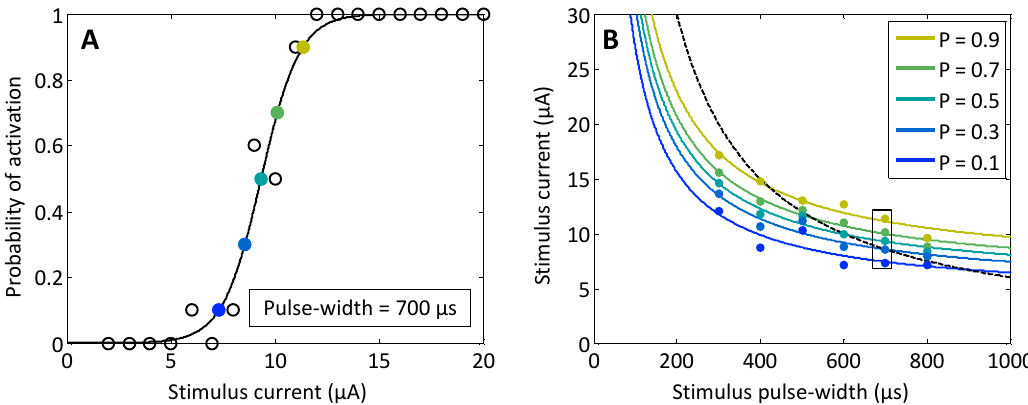
Figure 6. Strength–duration curve fitting from neuronal activation data. A randomized set of 1140 stimuli were delivered to the MEA spanning 2–20 μ A in 1 μ A increments and pulse widths spanning 300–800 μ s in 100 μ s increments. Each stimulus was randomly repeated ten times to measure the activation probability with 0.1 resolution. ( A ) Average responses for each stimulus current with a 700 μ s pulse width are plotted with open circles. Below 6 μ A, no action potentials were detected, and above 11 μ A action potentials were detected 10 out of 10 times. A non ‐ linear least squares curve ‐ fit of the sigmoid in Equation 1 was performed on the 700 μ s data. The best fit is shown by the solid line. The sigmoid model was used to predict the stimuli that would produce activation probabilities ranging from 0.1 to 0.9 in 0.2 steps (closed circles, increasing probability from dark to light); ( B ) Model ‐ predicted stimuli from ( A ), corresponding to activation probabilities ranging from 0.1 to 0.9, were plotted with solid circles and are outlined with a box. In the same manner as ( A ), sigmoid models were built for each of the sets of stimulus pulse ‐ width data spanning 300–800 μ s. These models were again used to predict a set of stimulus currents for the range of probability levels (vertical sets of solid circles). Strength ‐ duration curves (solid lines) for each of the probability levels were created from a non ‐ linear least squares curve ‐ fit to the predicted points from the model in Equation (2). The shade of each curve corresponds to the equivalent probability level in ( A ). Probability steps of 0.2 were chosen for clarity. A constant ‐ charge curve (6 nC) is shown as a reference (dotted line).